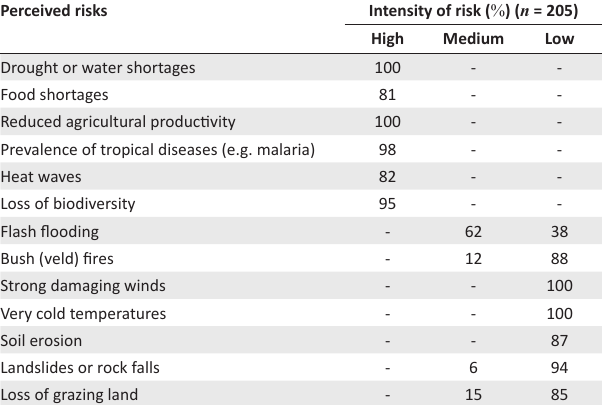
TABLE 2: Karat respondents’ perceptions of climate-change-induced